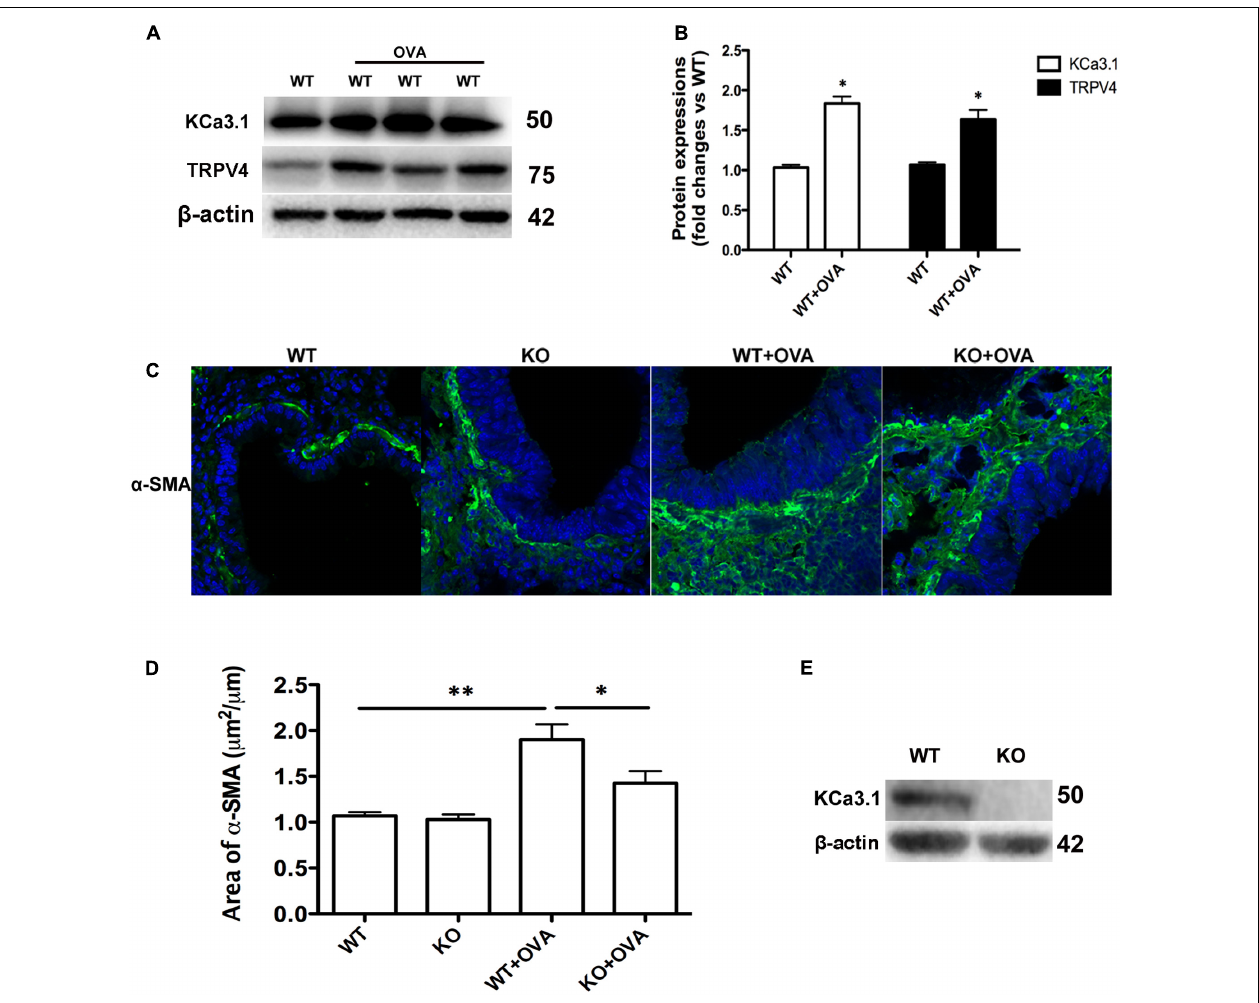
FIGURE 4 | Gene deletion of KCa3.1 prevented OVA-induced up-regulation of α -SMA. (A) The KCa3.1 and TRPV4 proteins expressions in the lung sections from WT and WT + OVA groups mice. (B) Data were presented as means ± SEM ( n = 5). ∗ p < 0.05, unpaired, two-tailed Student’s t -test compared with WT mice. (C) Representative photomicrographs of immunofluorescence reactivity of lung sections from WT, KO, WT + OVA, and KO + OVA groups mice using antibody against α -SMA (original magnification, x 40). (D) Plot of means ± SEM measurements of the area α -SMA + staining per µ m length of bronchi basement membrane. n = 4, ∗ p < 0.05, ∗∗ p < 0.01, Kruskal–Wallis test followed by Dunn’s multiple comparison test compared with WT + OVA mice. (E) Western blot showing the absence of KCa3.1 expression in the lung tissues of KCa3.1 KO mice. WT, wildtype; KO,